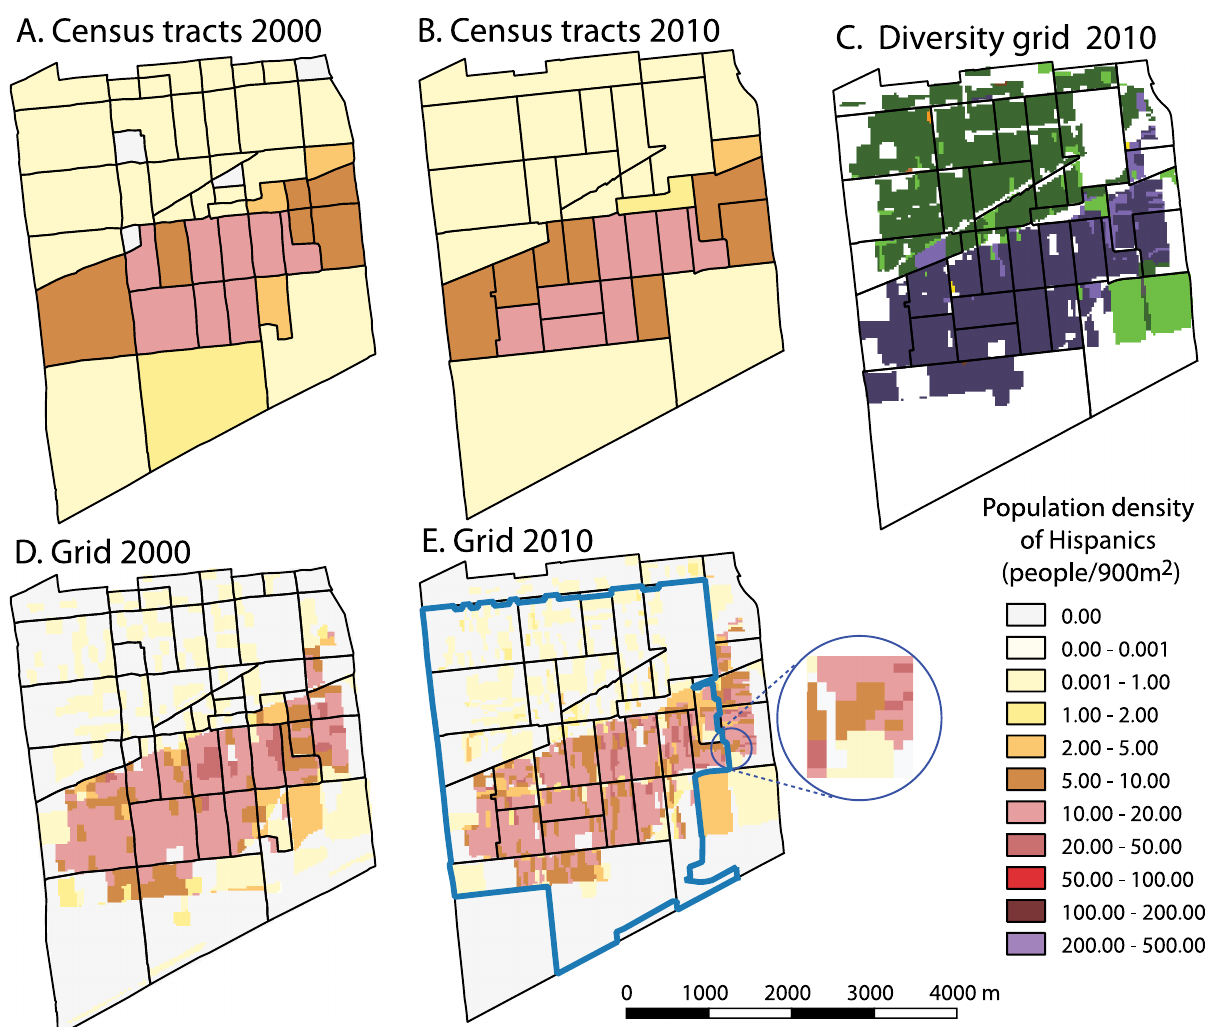
Fig 1. Maps showing distribution of the Hispanic population in central Chicago according to Census tracts (panel A for 2000 and panel B for 2010) and according to high resolution grids (panel D for 2000 and panel E for 2010). Census tracts boundariesare overlaid on grid-basedmaps for reference. Extent of the ZIP Code is shown in blue. Inset in panel E is to show the high (30m) resolutionof the grid. Racial diversity grid-based map (D) shows spatial extents of two communities, Blacks-dominated(green color) and Hispanic- dominated (violet